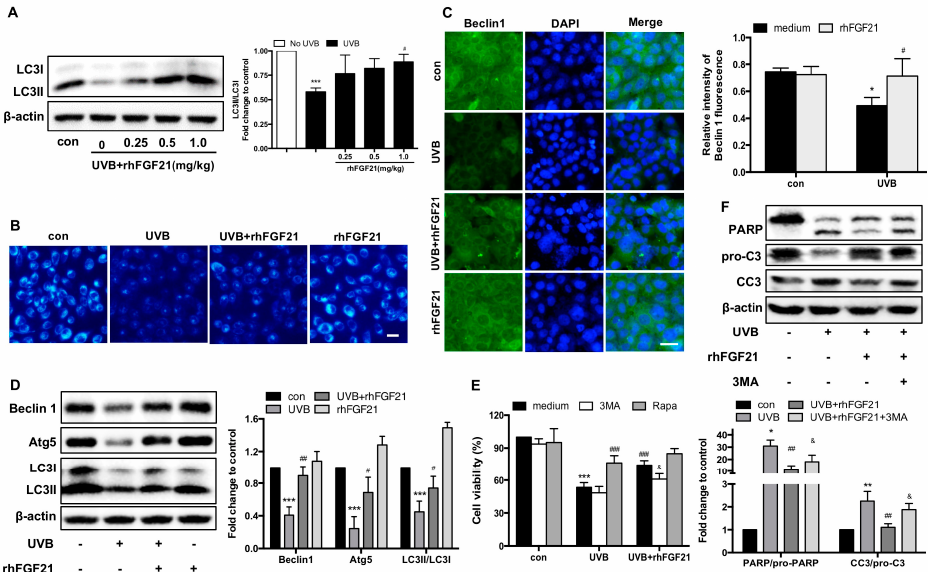
Figure 5. RhFGF21 rescues UVB-irradiated HaCaT cells by inducing autophagy. ( A ) The expression of LC3 protein was detected by Western blot analysis, and quantitative analysis of the intensity of LC3 II/LC3 I. ( B ) Cells were stained with MDC solution. Morphological changes were observed by fluorescence microscopy. Blue fluorescence represents autophagy levels. Scale bar = 25 μ m. ( C ) Immunofluorescence confocal microscopy images of Beclin 1 in HaCaT cells. Green fluorescence represents the expression of Beclin 1 protein, blue fluorescence represents nucleus DAPI. Scale bar = 25 μ m. Quantitative analysis of the intensity of Beclin 1. ( D ) The protein levels of Beclin 1, Atg5 and LC3 were detected by Western blot analysis. ( E ) Cells treated with or without an autophagy activator (rapamycin, Rapa, 20 μ M) or autophagy inhibitor (3-methyladenine, 3MA, 1 mM). Cell viability was determined by MTT assay. ( F ) Western blot analysis of PARP, caspase-3 and active caspase-3 (CC3) levels. Quantitative analysis of PARP and CC3/pro-C3 levels. Data are means ± SD of three independent experiments, * p < 0.05, ** p < 0.01, *** p < 0.001 versus epidermal cells or HaCaT cells not exposed to UVB radiation; # p < 0.05, ## p < 0.01, ### p < 0.001 versus UVB-irradiated epidermal cells or HaCaT cells; & p < 0.05 versus rhFGF21-treated HaCaT cells injured by UVB